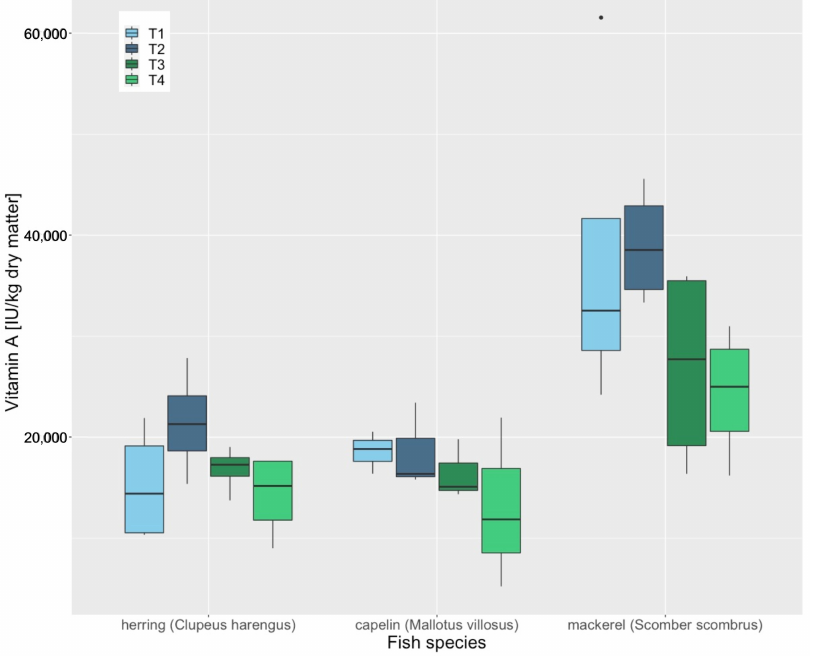
Figure 1. Vitamin A concentrations of whole frozen herring (Clupeus harengus), mackerel (Scomber scombrus) and capelin (Mallotus villosus), thawed in the refrigerator (4 ◦ C for 24 h), and measured at 4 different time points. T1, day of delivery, T2, 60 days after, T3, 120 days after, T4, 180 days after delivery. “ • ” are outliners.